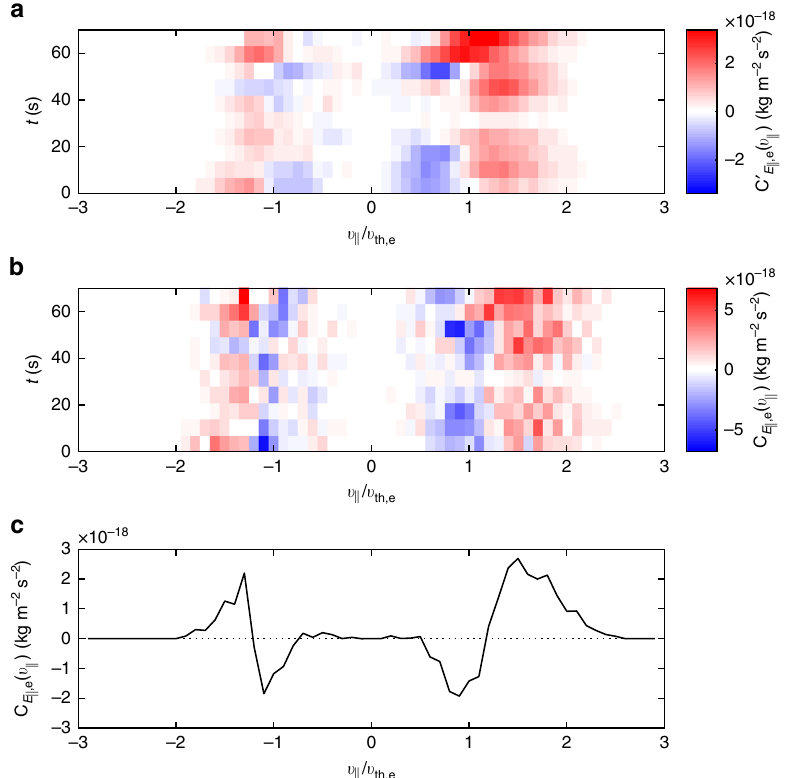
ð v Þ as a function of time t . b 1D energy transfer rate C jj jj ; e